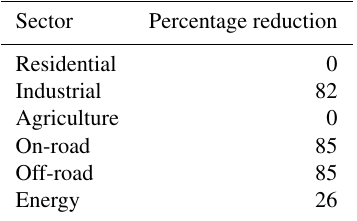
Table 2. Percentage reduction in anthropogenic emissions in India during the COVID-19